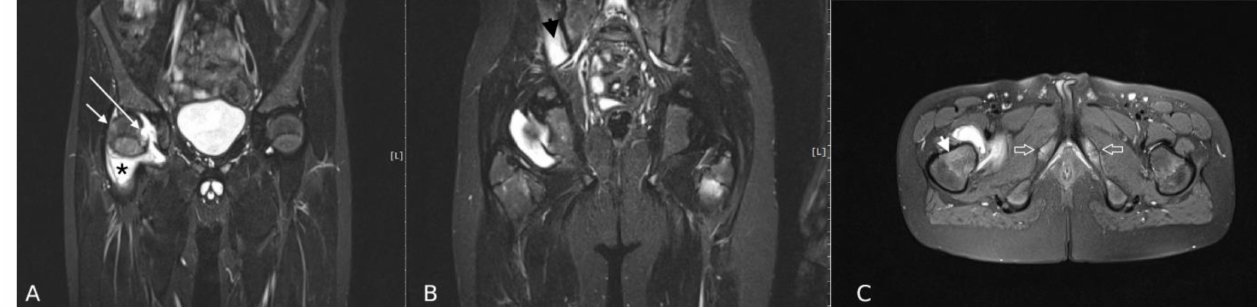
Figure 1. MRI of the hips in a 10-year-old boy with JIA: ( A , B ) Coronal T2 TIRM, ( C ) Axial T2 TIRM images. Right hip: joint effusion (stage 3), synovitis (stage 1) (asterisk), BME in femoral head (stage 1) (white short arrow), BME in the neck of femur (stage 2) (arrowhead on “C”), erosion in the femoral head (white long arrow). Left hip: BME in the femoral neck (stage 2). Right sided sacroiliitis (arrowhead on “B”). Involvement of ischiopubic synchondrosis bilaterally (empty arrows on “C”).